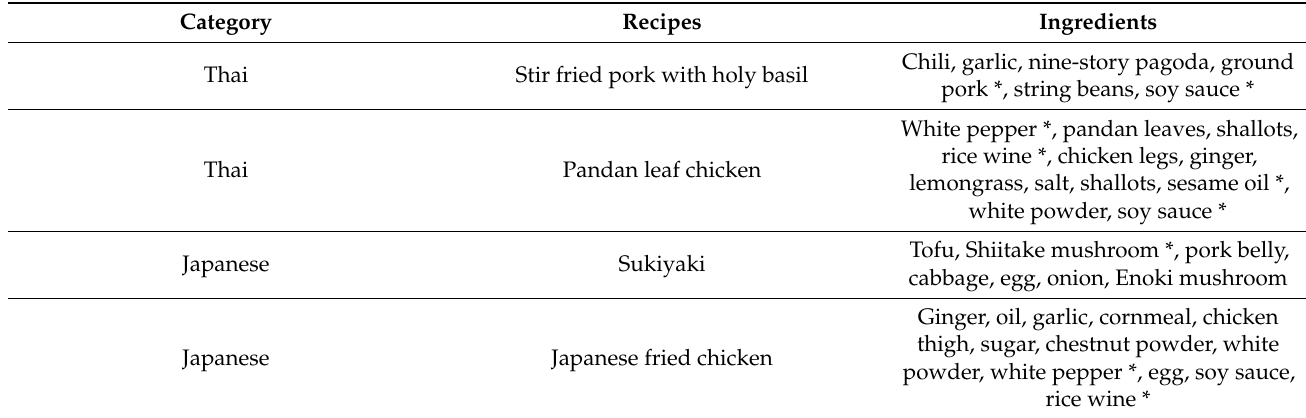
Table 13. Examples of recipes that are misclassified as